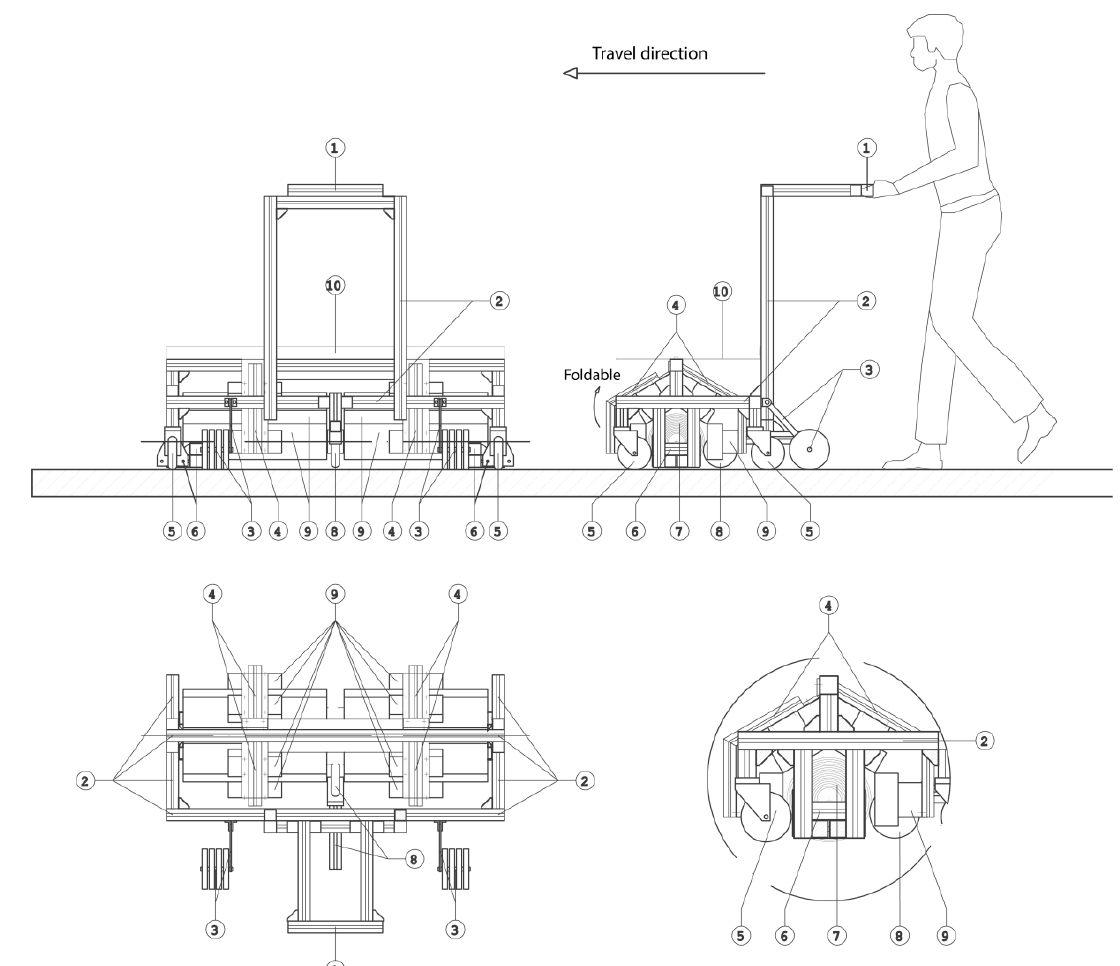
Figure 1. Orthogonal views of the design: 1 — handles, 2 — structure of the trolley, 3 — drum rollers, 4 — structure of heaters, 5 — wheels, 6 — roll stop sides, 7 — asphalt roll, 8 — auxiliary wheel, 9 — heaters, and 10 — enclosure cover.